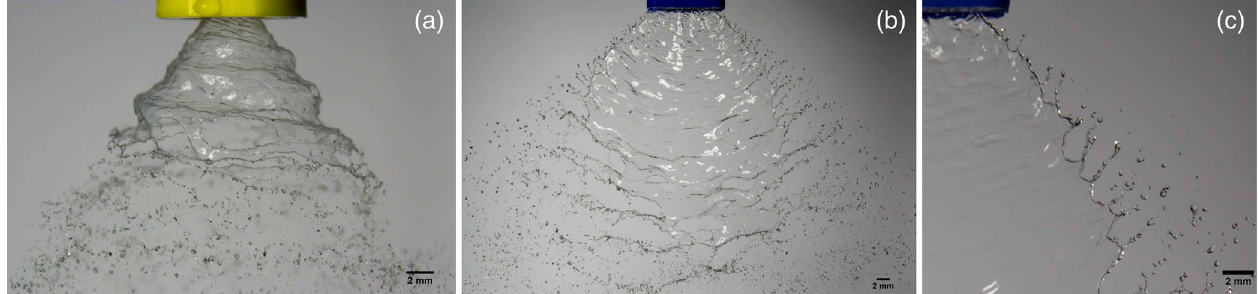
FIG. 1. (a) Picture of the conical nozzle with an operating pressure of 2.0 bar. The Squire wave is clearly visible, with a wavelength in agreement with the prediction. (b) The flat fan nozzle at 2.0 bar, with flapping and breakup occurring near the bottom of the picture. (c) Zoomed-in picture of the flat fan nozzle at low pressure (1.0 bar), showing droplets coming from the sheet ’ s rim that are of the order of the nozzle